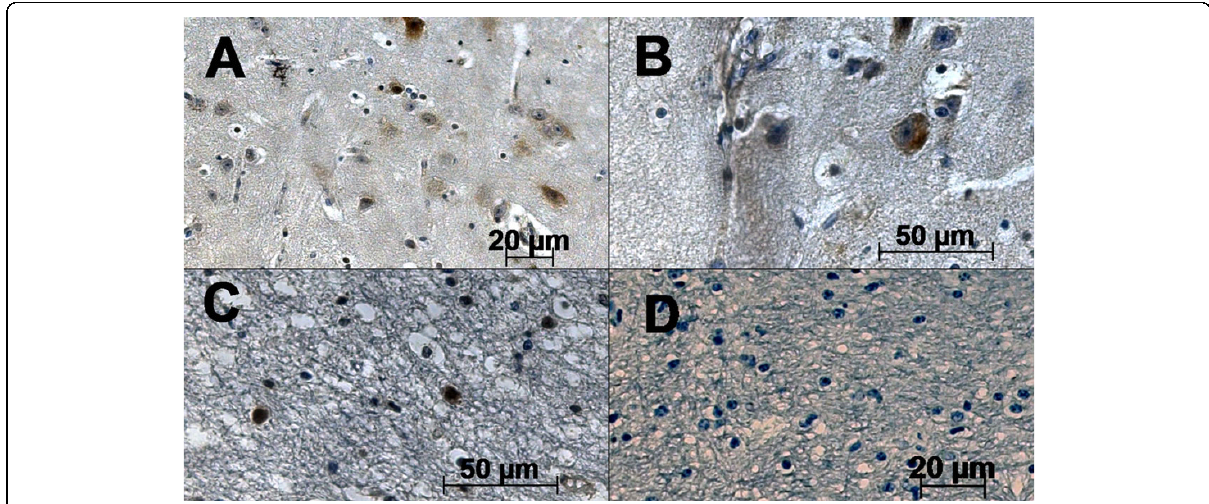
Figure 6 Photomicrography of in situ hybridization assay . A) positive detection of US9 BoHV-5 gene in brain cells; B) positive reaction in neurons; C) positive reaction in glial cells; D) control group. The strepavidin-biotin peroxidase complex method was used (scale bars 20 and 50 μ